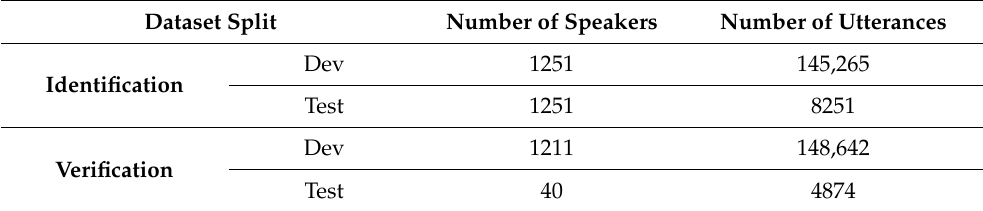
Table 4. Development and Test Split of VoxCeleb1 dataset for identification and